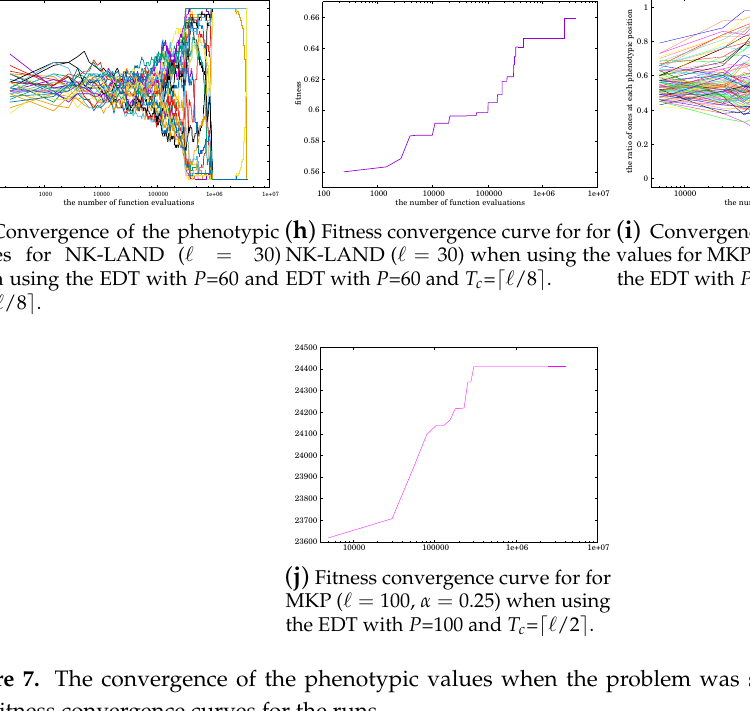
( f ) Fitness convergence curve for for HDEP ( (cid:96) = 30) when using the EDT with P =100 and T c = (cid:100) (cid:96) /2 (cid:101) .